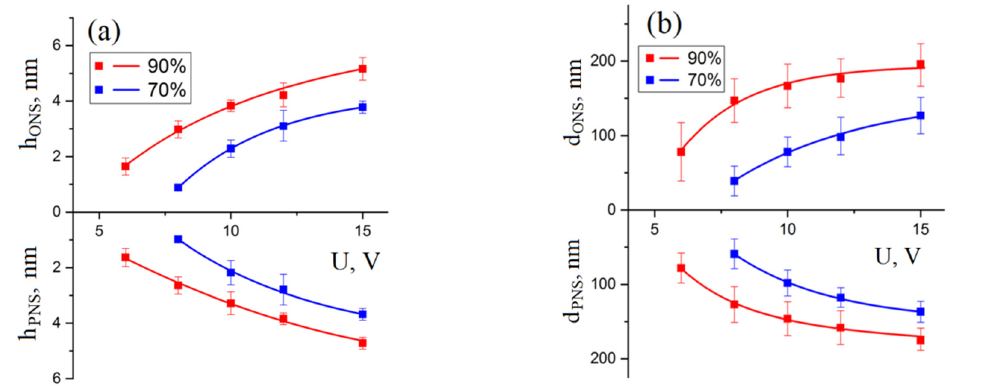
Figure 3. Dependences of the geometric parameters of nanostructures on the voltage amplitude, pulse duration 500 μ s, feedback current 2 nA, air humidity 1—90 ± 1% and 2—70 ± 1%: ( a )—the height of